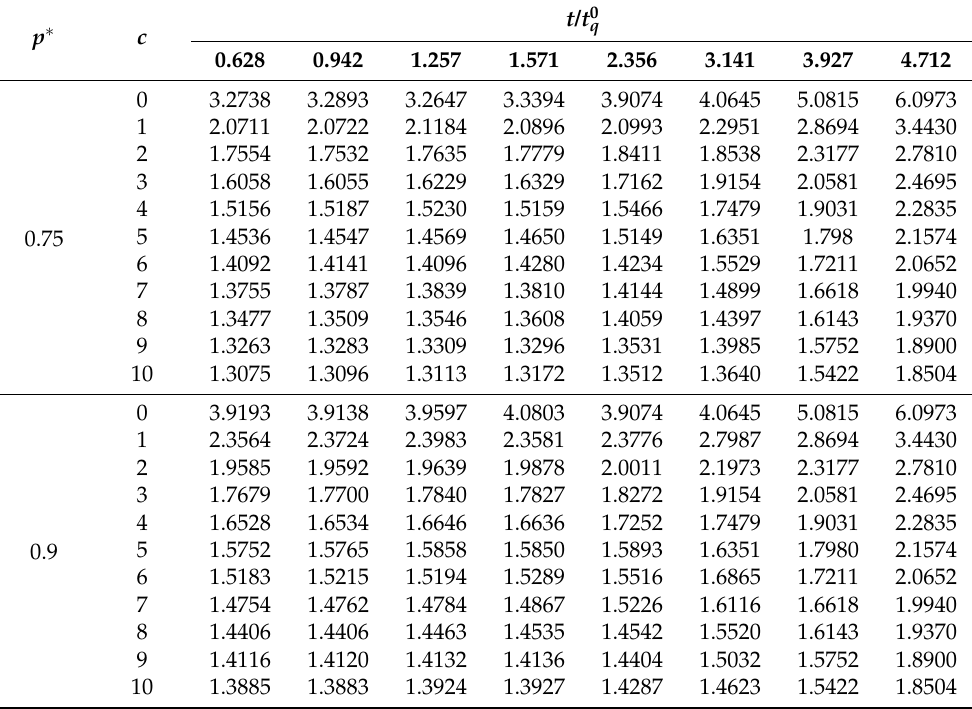
Table 5. Minimum ratio of d 0 for the acceptability of a lot with producer’s risk 0.05 with η = 2.793 0.1 and α = 1.011 for the